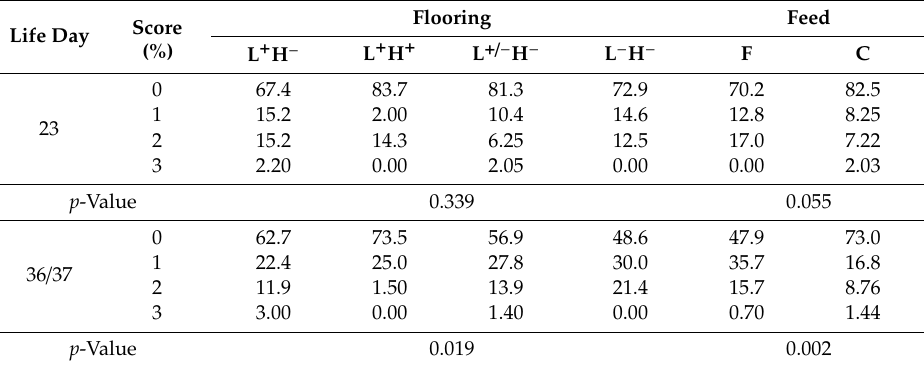
Table 6. Scoring of Isthmus gastrici (%) in broilers at dissection